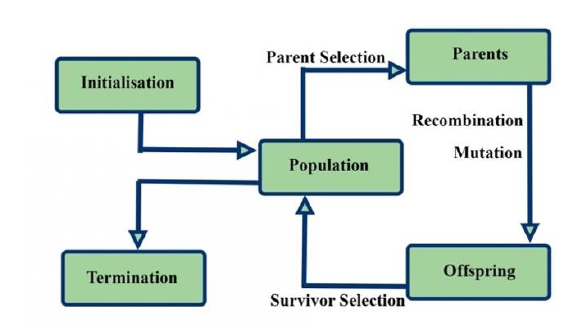
Figure 2. Genetic algorithm.